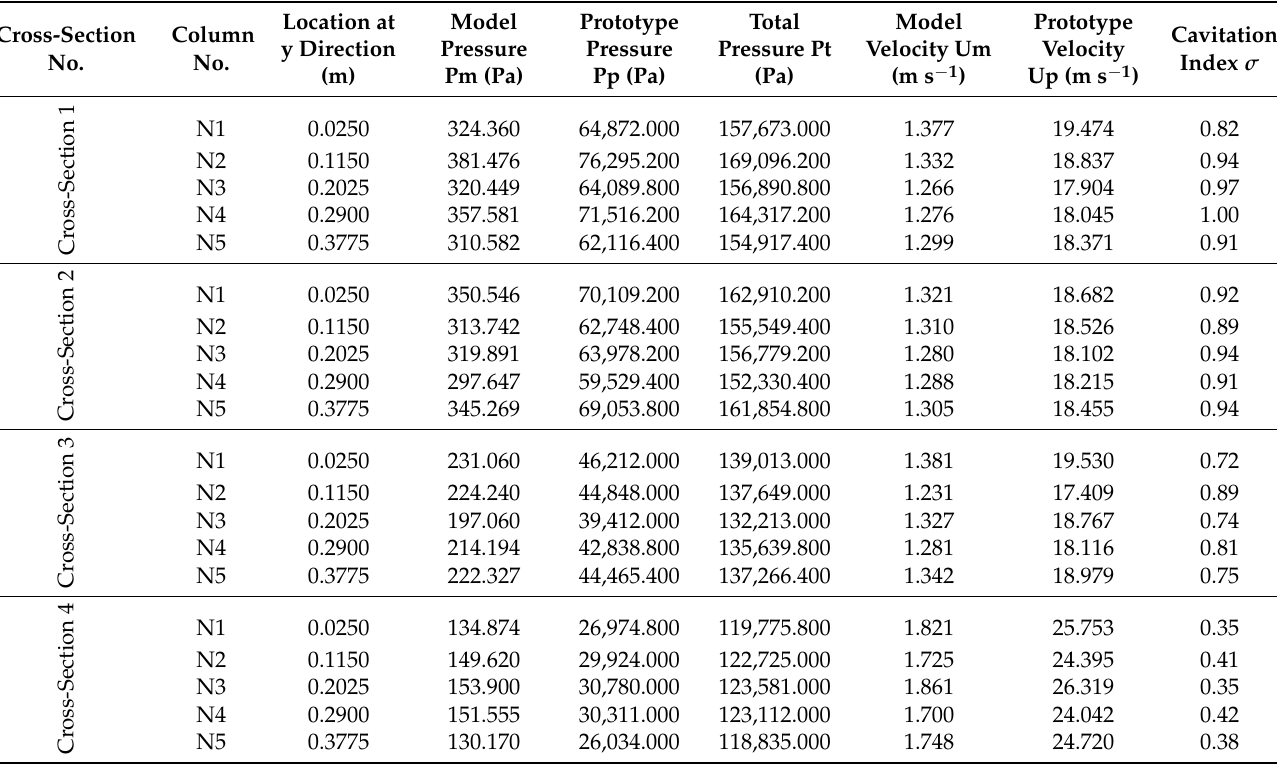
Table 6. Cavitation indices for prototype